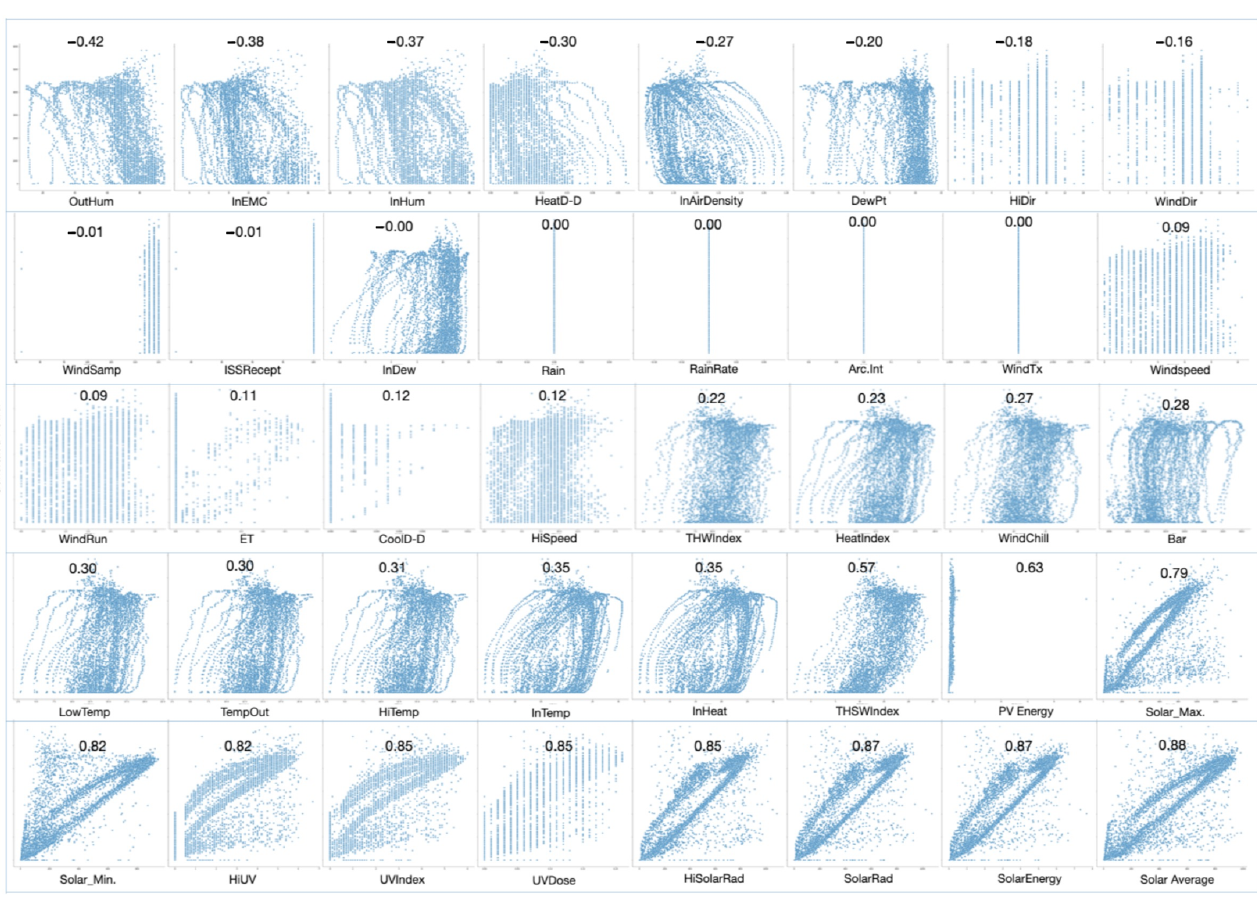
Figure 6. Correlation